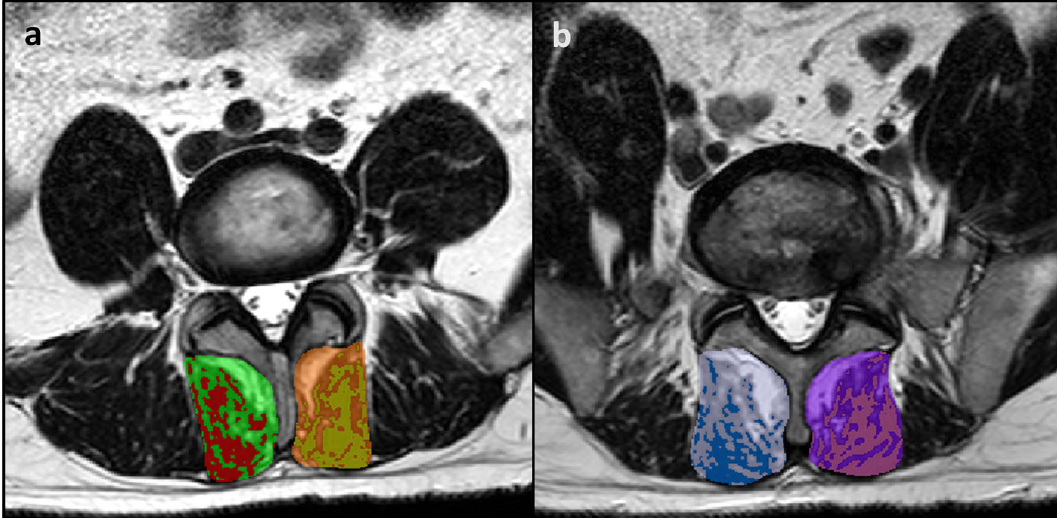
Figure 2. Multifidus muscle total CSA and % MCSA. ( a ) bilateral total CSA (L4), with red and gold highlights indicating the right and left peak muscle CSA, respectively; ( b ) bilateral total CSA (L5), with blue and pink highlighting the right and left peak muscle CSA, respectively. Note This method did not select all potential muscle signal; only the “purest” muscle tissue was